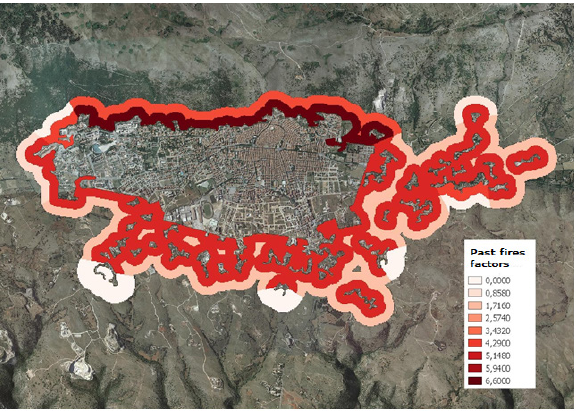
Figure 9 . Map of Past Fires